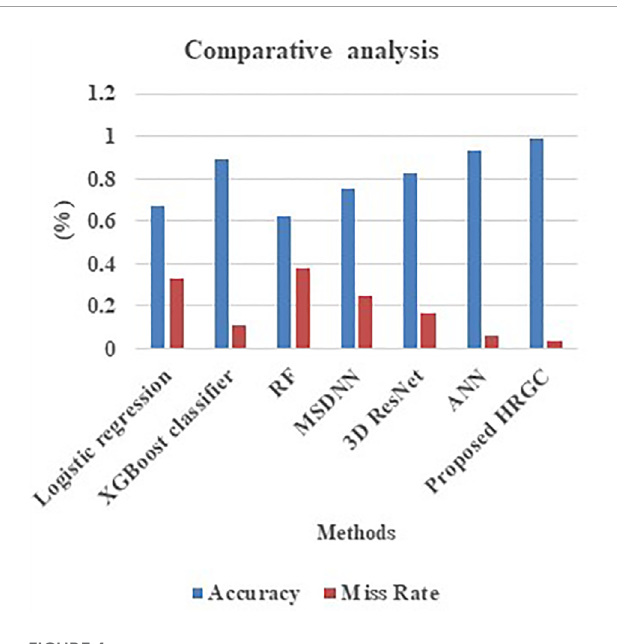
FIGURE 4 Performance comparison of accuracy and miss rate.